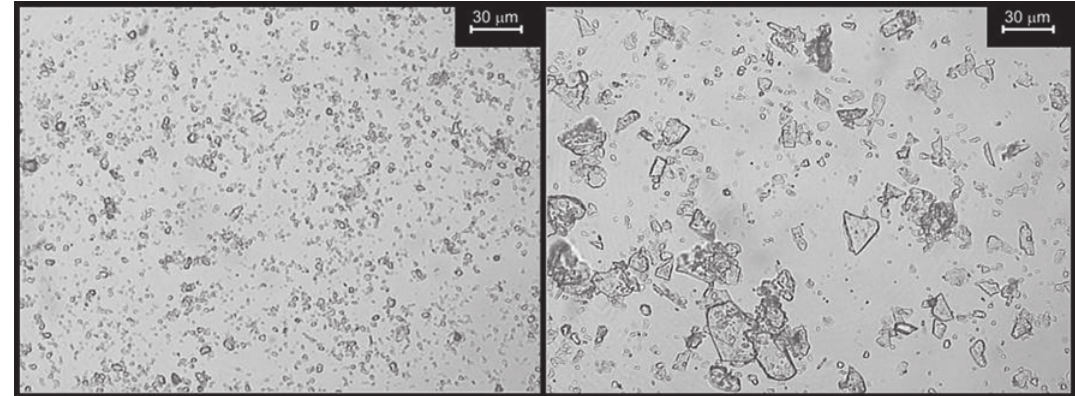
Figure 1 - Talc samples used. Left, talc containing small particles (< 5 µm). Right, mixed talc (90% of particles > 10 µm). Magnification: